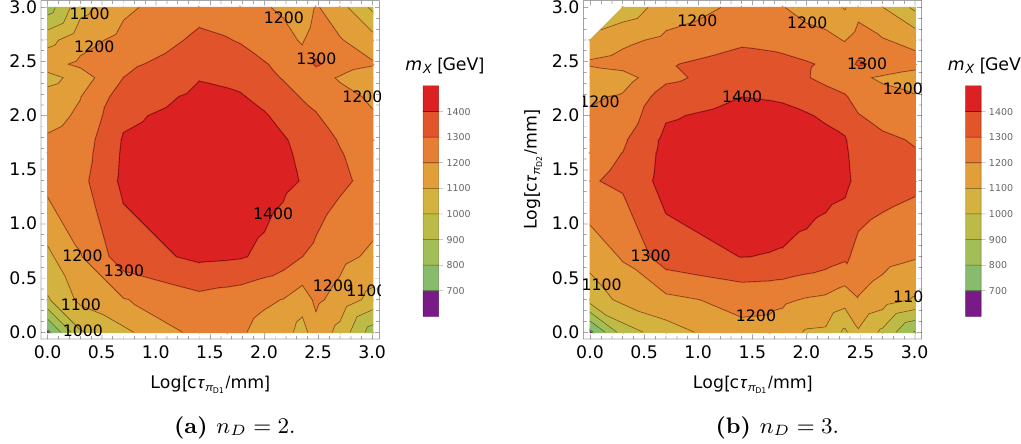
Figure 8. Same as figure 7, but for the emerging jets